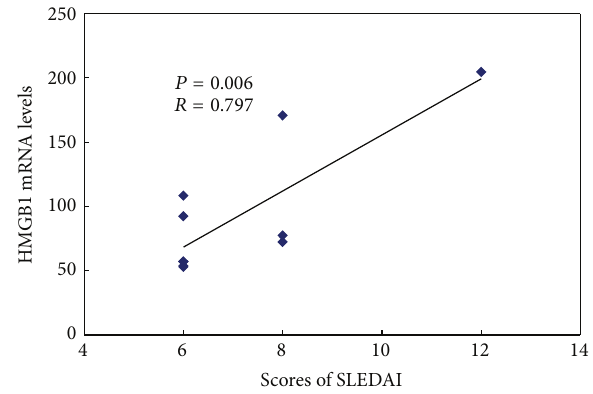
Figure 5: Correlation between HMGB1 mRNA and SLEDAI. Lupus disease activity was quantified by the SLE Disease Activity Index (SLEDAI). Correlation between HMGB1 mRNA in lupus CD4 + T cells and SLEDAI for lupus patients is